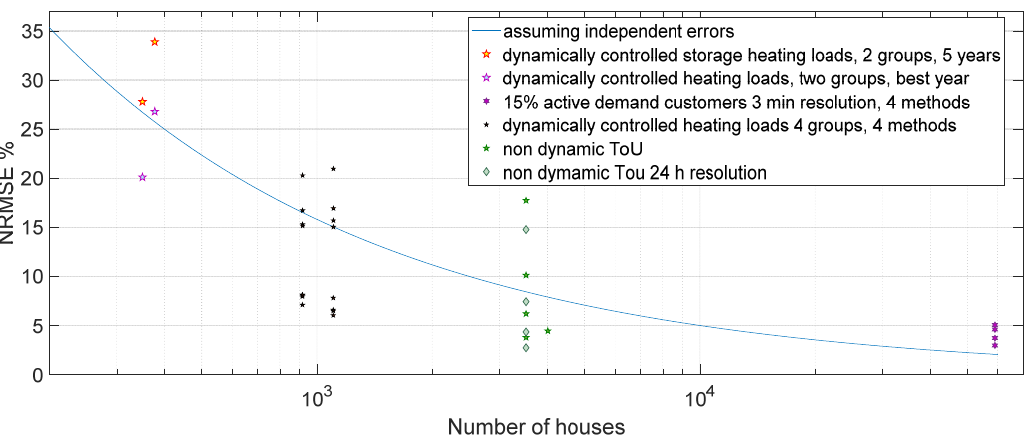
Figure 3. Load forecasting accuracy as a function of the number of aggregated customers as collected from our own published results. The results support the assumption of independent errors except for the largest group size and the other differences reduce the comparability among the cases much more.